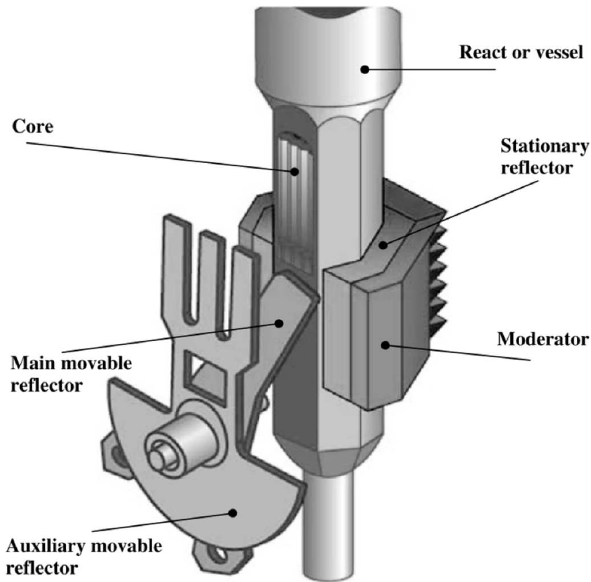
Fig. 9. Reactivity modulator of the IBR-2 reactor: two rotating reflectors